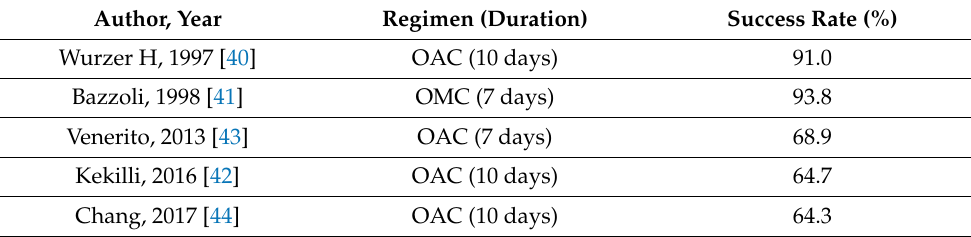
Table 3. Reduction in the efficacy of triple therapy in the decades 1997–2017. Author,